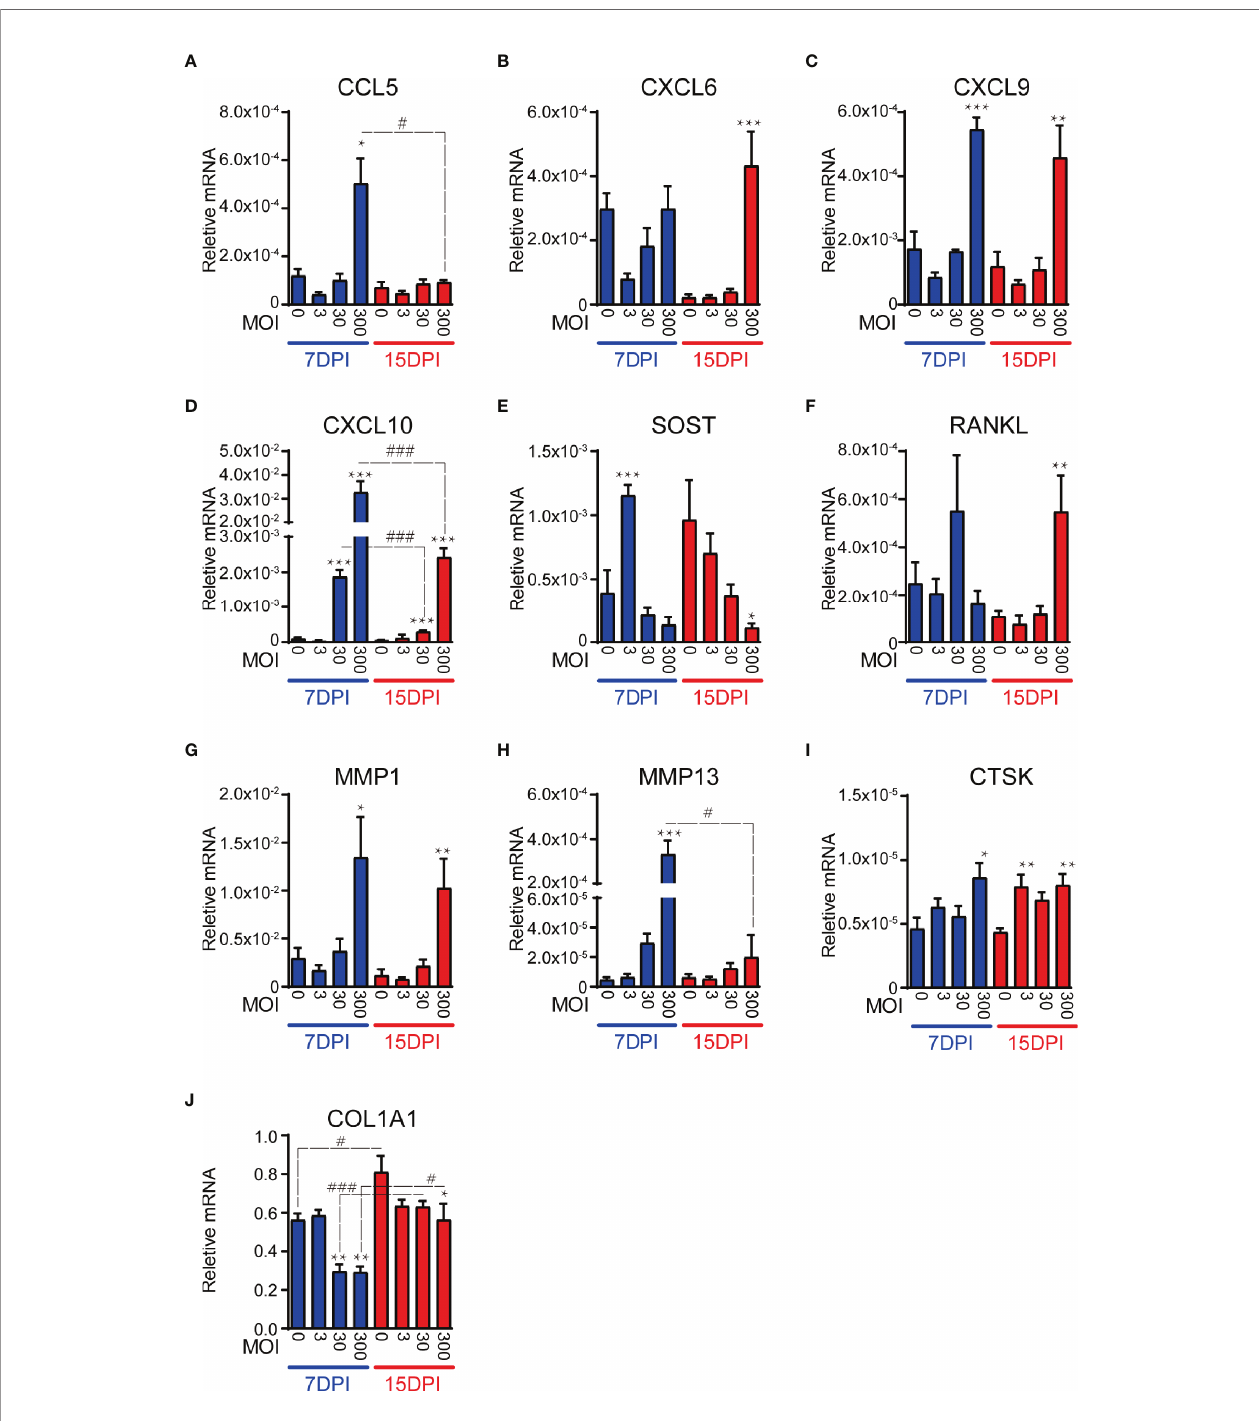
FIGURE 3 | SaOS2-OY gene expression modulation in response to a logarithmic dose range of WCH-SK2 infection over time. Gene expression was normalised to that of the housekeeping gene ACTB . Genes tested were either immunomodulatory (A – D) , osteocytic markers and mediators of bone turnover (E, F) or extracellular matrix effectors (G – J) . Data shown are means of biological triplicates each measured in duplicate ± standard error of the mean. Signi fi cant changes of the treatment group against the uninfected control within the same time point is indicated by *,**,*** signifying p < 0.05, 0.01, and 0.001, respectively, in an ANOVA multiple comparison test. Signi fi cant changes for the same MOI at different time points is indicated by # , ## , ### signifying p < 0.05, 0.01, and 0.001, respectively. MOI, multiplicity of infection; DPI, days